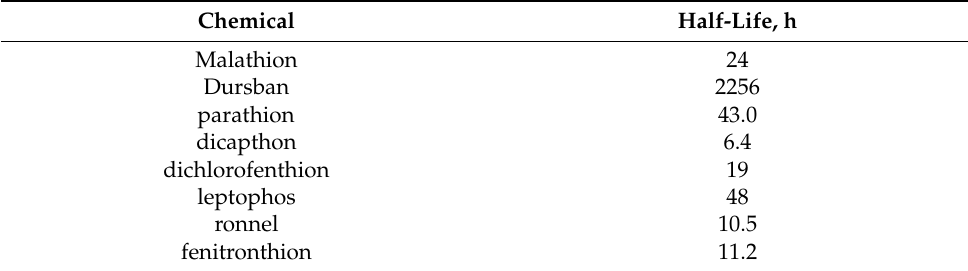
Table 4. The Half-life of some organophosphates